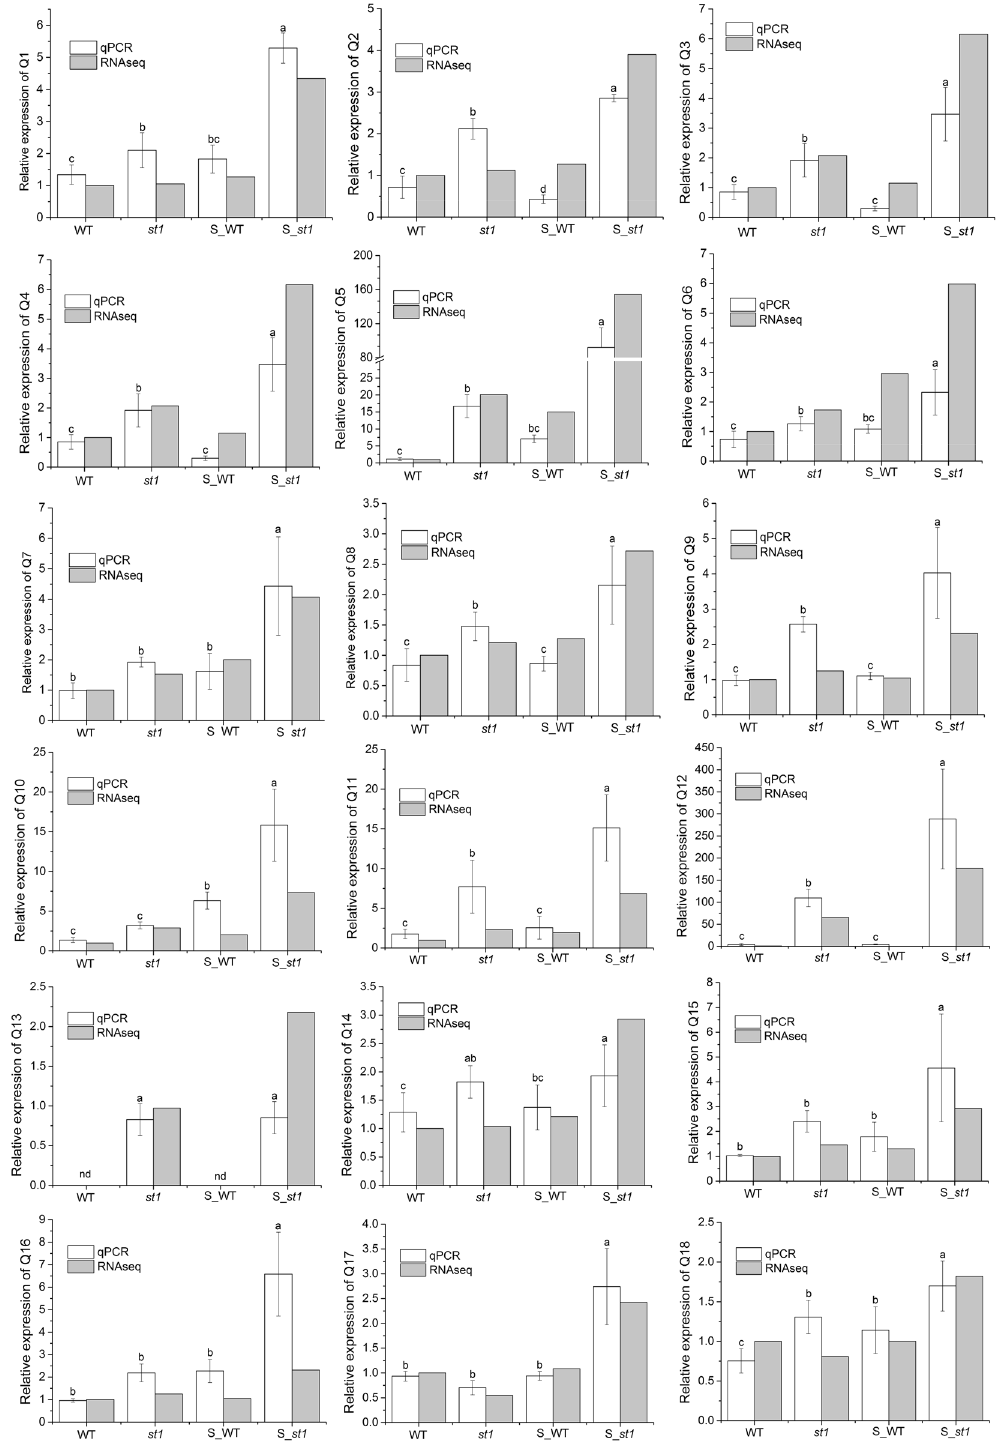
Figure 6. Expression patterns of selected genes in WT and st1 with and without salt treatment determined by RNA-seq and qPCR. The gene numbers (Q1–Q18) correspond to the gene labels in Table 2. The RNA-seq values represent the ratio of the expression level in st1 to the expression level in WT. The expression level for each sample is the average of two replicates. For qPCR, the data are means ± SD from three independent replicates, and different letters indicate significant differences between samples at P < 0.05 based on SAS statistic